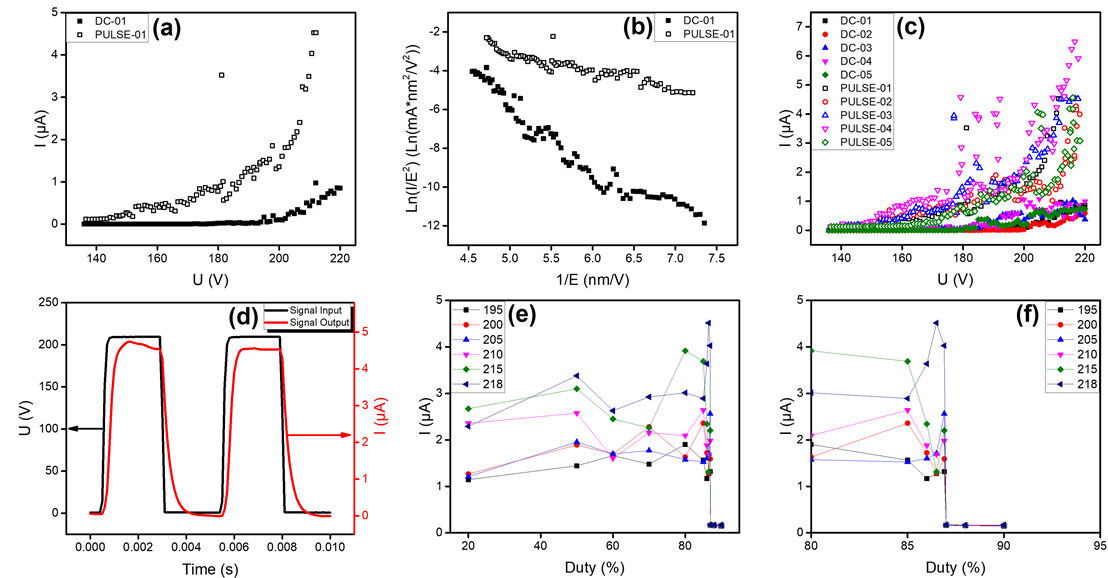
Figure 4. ( a ) Comparison of electron vacuum tunneling emission properties of SiC nanowire in DC and pulsed driving modes and ( b ) corresponding FN plots. ( c ) Diagram to illustrate the electron emission properties of 5 samples in different driving modes. ( d ) Pulsed waveform under pulsed driving mode collected by high-precision digital oscilloscope. ( e ) Diagram of current versus pulsed duty ratio under different pulsed peak voltages and ( f ) focus on the area of the image where the current drops sharply.